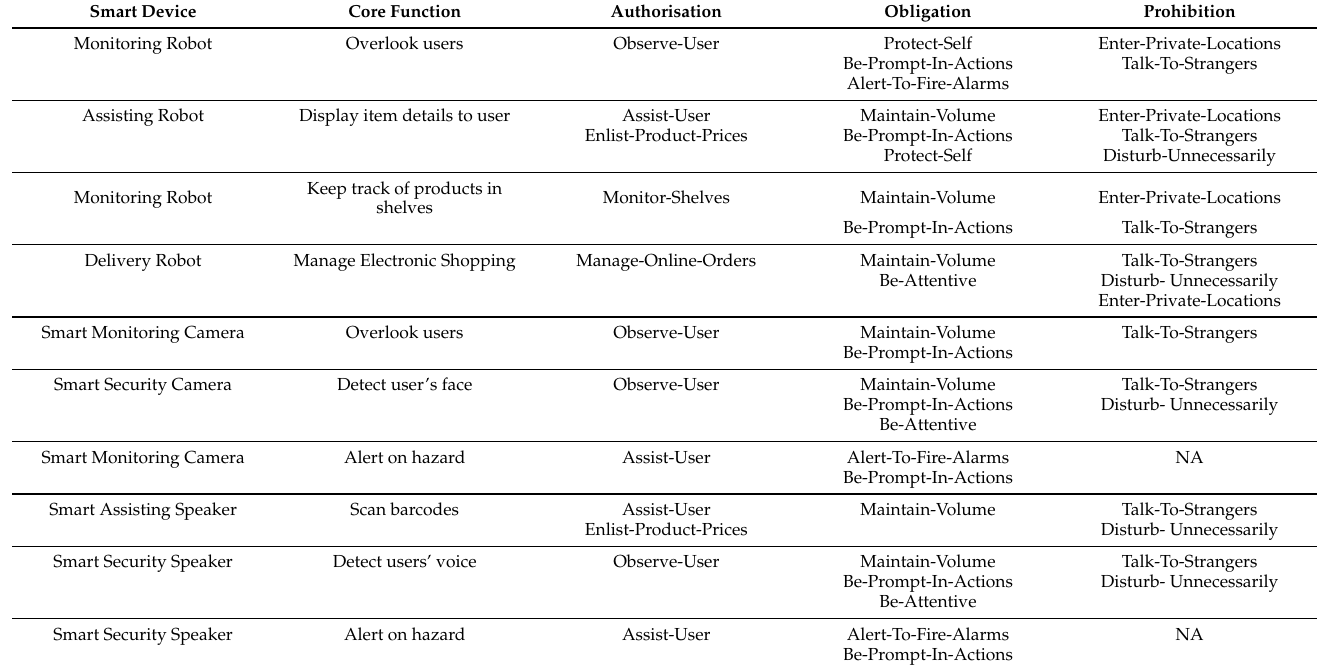
Table 3. Administrative policy rules and core functions mapping—supermarket scenario.